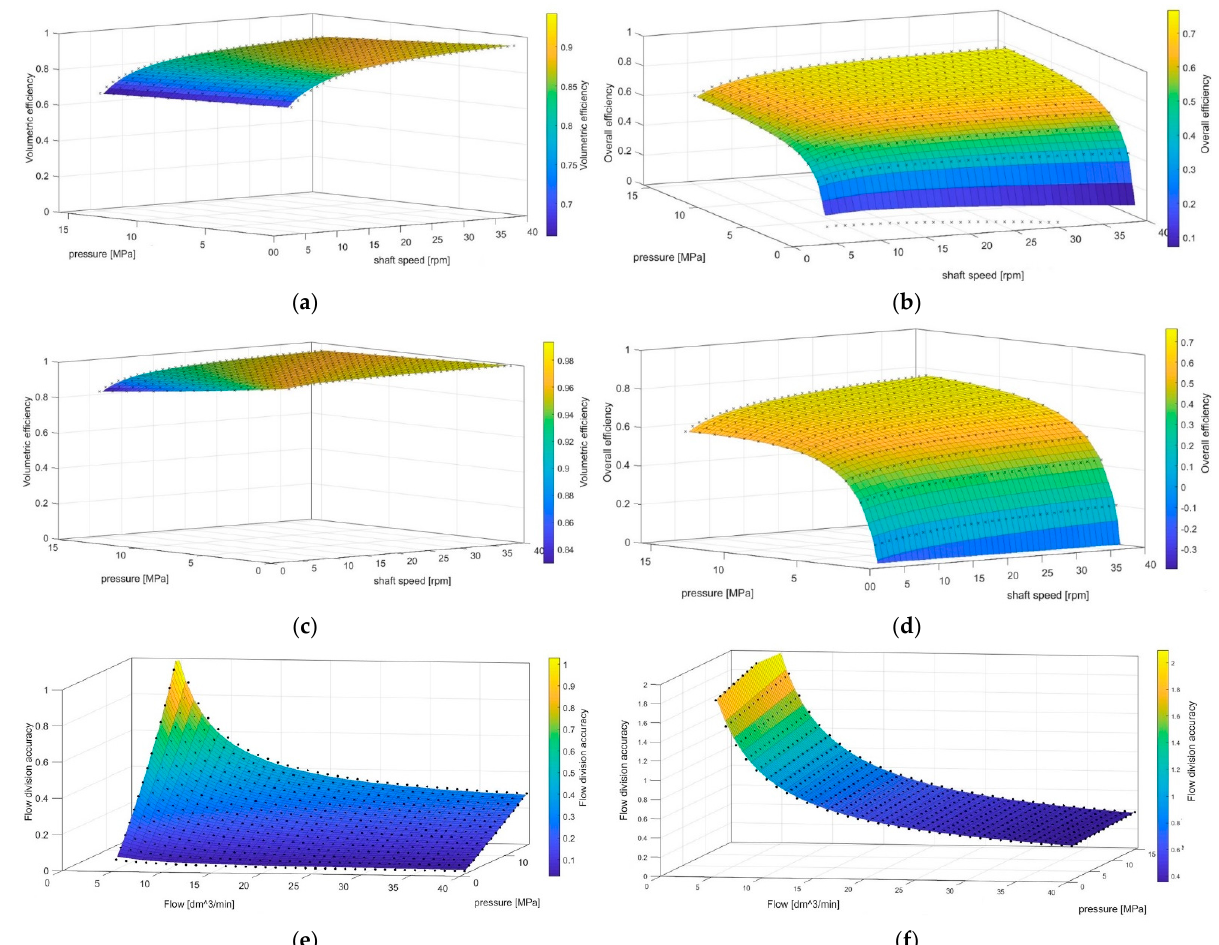
Figure 11. Characteristics of the hydraulic motor volumetric ( a ) and overall ( b ) efficiency, pump volumetric ( c ) and overall ( d ) efficiency, and spool ( e ) and gear-type ( f ) flow divider’s dividing accuracy [17].